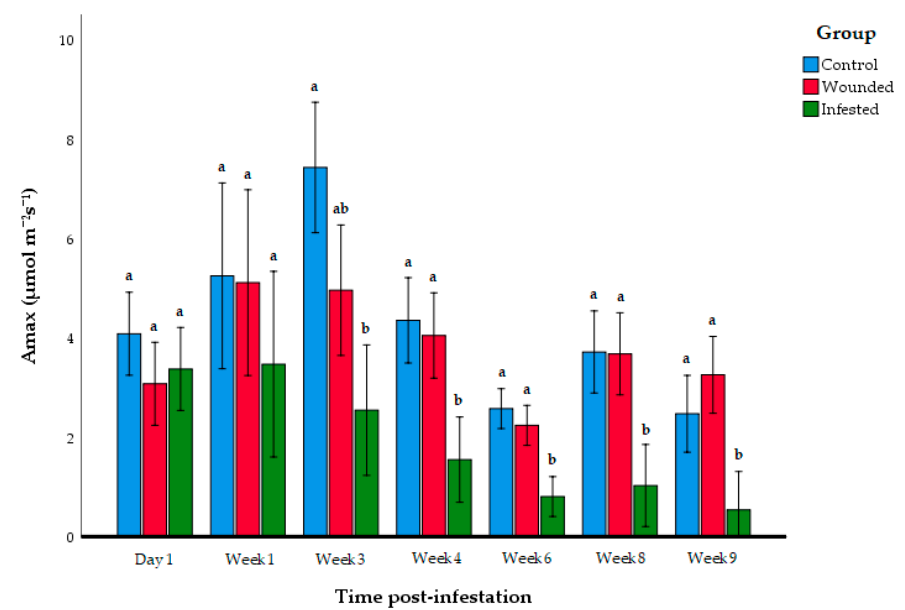
Figure 3. Mean maximum photosynthesis rate (A max ) of each E. guineensis group at different time post-infestation. Data shown as mean + S.D. Different letters indicate significant differences among the control, wounded, and infested group at each time post-infestation period based on ANOVA following the Tukey multiple comparison test ( p > 0.05). Table 2. Mean ± SD and results of one-way ANOVA of the maximum photosynthesis rate (A max ) at each time post-infestation. Different letters indicate significant differences based on ANOVA following Tukey multiple comparison test ( p > 0.05) .